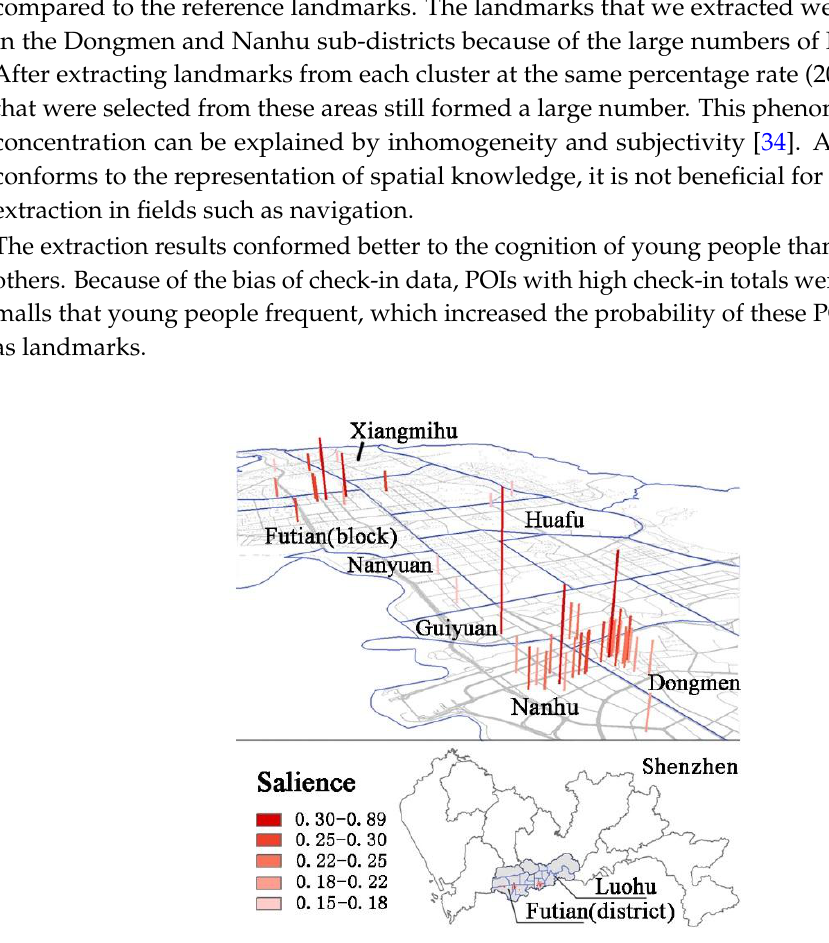
Figure 6. Mall Landmarks in the Luohu and Futian Districts.